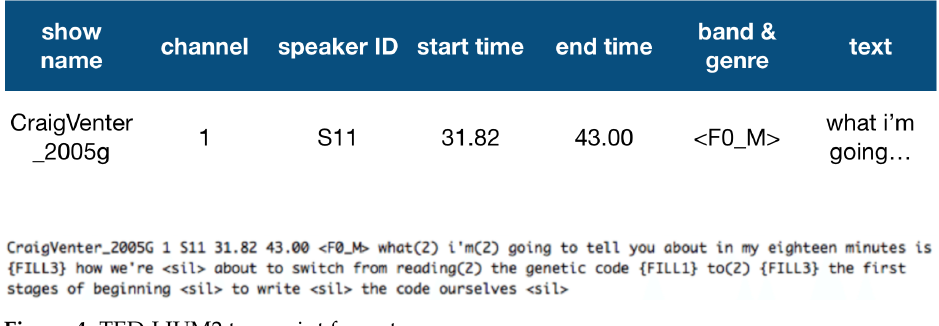
Figure 4. TED-LIUM2 transcript